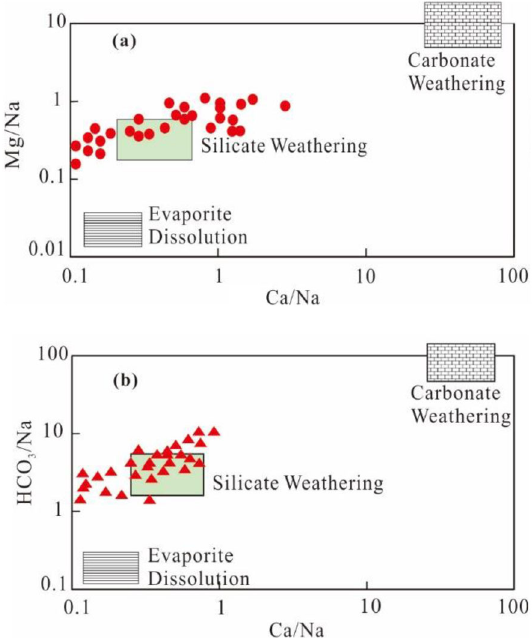
Fig. 5 Plot of a Na-normalized Ca 2 ? versus HCO 3 - ; b Na-normal- ized Ca 2 ? versus Mg 2